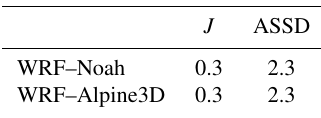
Table 6. Mean values of the Jaccard index and average symmetric surface distance for WRF–Noah and WRF–Alpine3D for the three snow